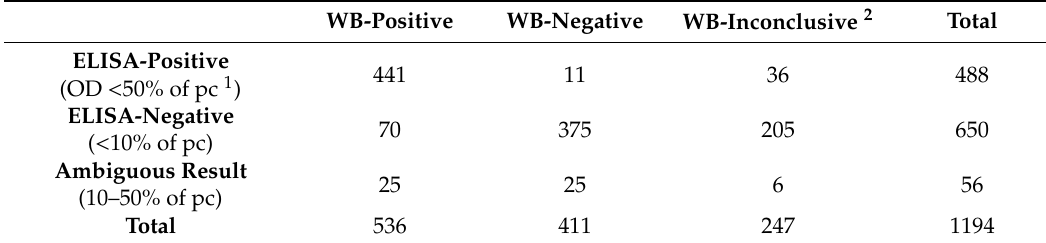
Table 2. Comparison of FIV WB and FIV ELISA